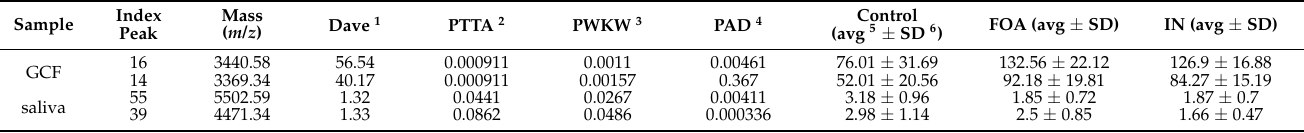
patients with oral health (red) and FOA (green) and IN (blue) patients. The discriminating attributes of the first two peaks from the list of p values. Ellipses correspond to 95% confidence intervals. Table 2. The most discriminating protein or polypeptide ions included in the cluster analysis by 2D peak distribution were statistically analysed using ClinProTools software.